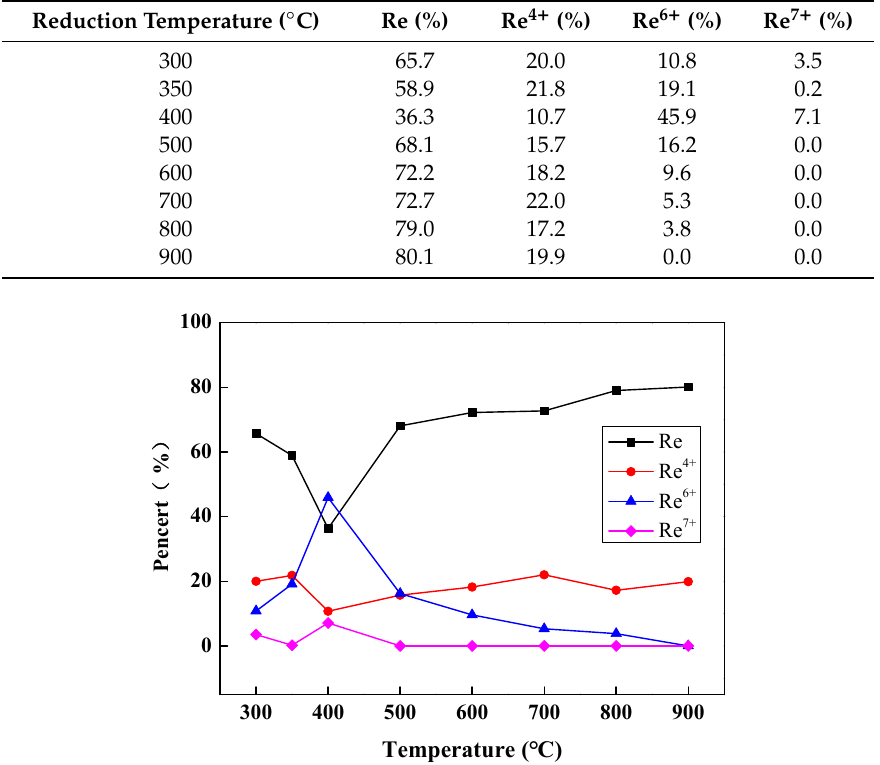
Figure 8. Oxidation state atomic content changes of ammonium perrhenate (D 50 was 81.05 µm, specific surface was 21.72 m 2 /kg) hydrogen reduction reaction at different temperatures.